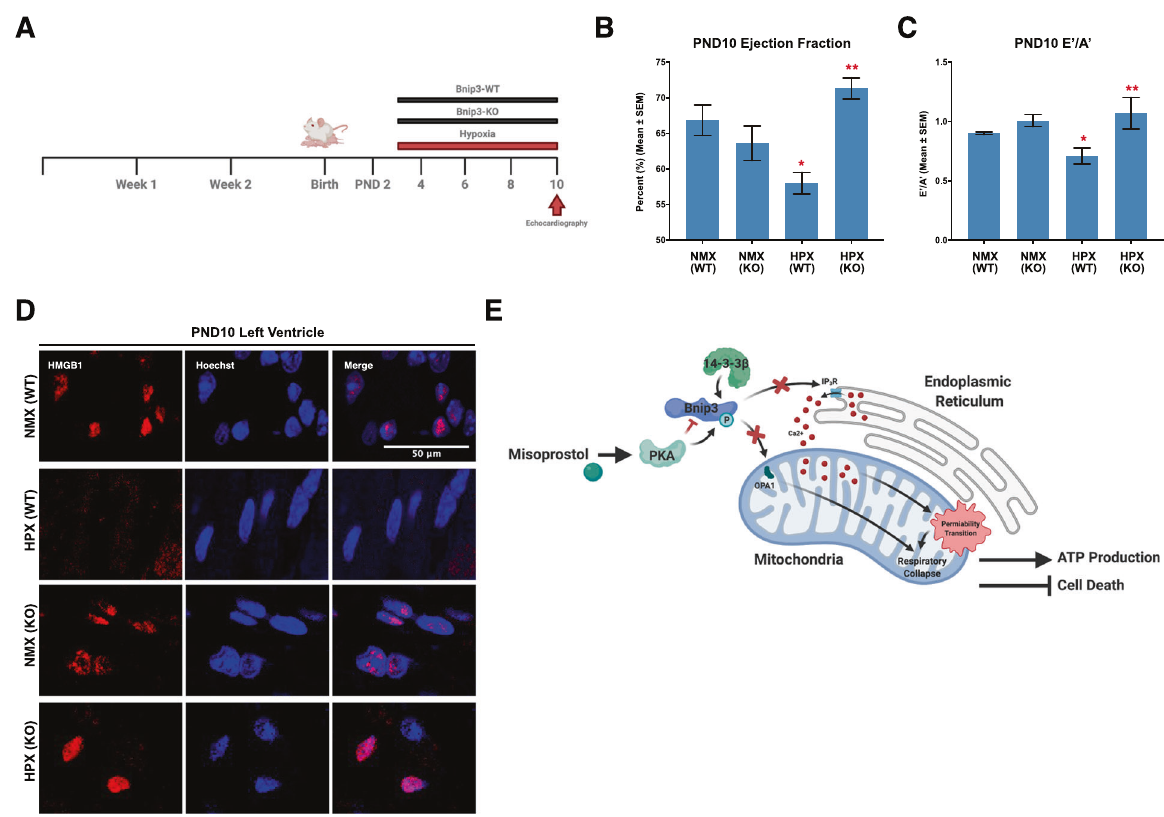
Fig. 7 Bnip3 ablation prevents hypoxia-induced contractile dysfunction and necroin fl ammation in the PND10 neonatal heart. A Post- natal day 2 (PND2) Bnip3-WT and Bnip3-null mice are exposed to hypoxia (10% O 2 ) from PND3-10, hearts were imaged and collected on PND10. B Ejection fraction and ( C ) E ’ /A ’ ratio for PND10 animals treated as in ( A ), in 3-5 mice per group, as determined by transthoracic echocardiography. D PND10 hearts treated as in ( A ) and stained with DAPI (Blue) and probed for high mobility group box 1 (HMGB1, red). Hearts were imaged via € focal microscopy. E Proposed mechanism by which misoprostol inhibits Bnip3 at the mitochondria and ER to prevent necrotic cell death and necroin fl ammation. All data are represented as mean ± S.E.M. *P < 0.05 compared with WT control, while **P < 0.05 compared with WT hypoxia treatment, determined by 1-way